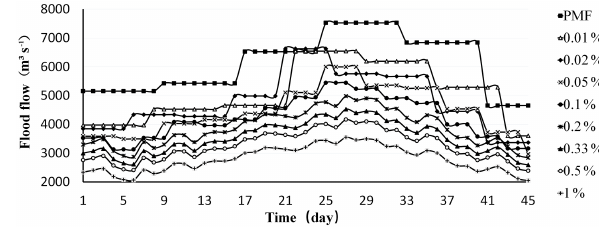
Figure 2. The change process of time-varying design flood at 9 kinds of design frequencies.